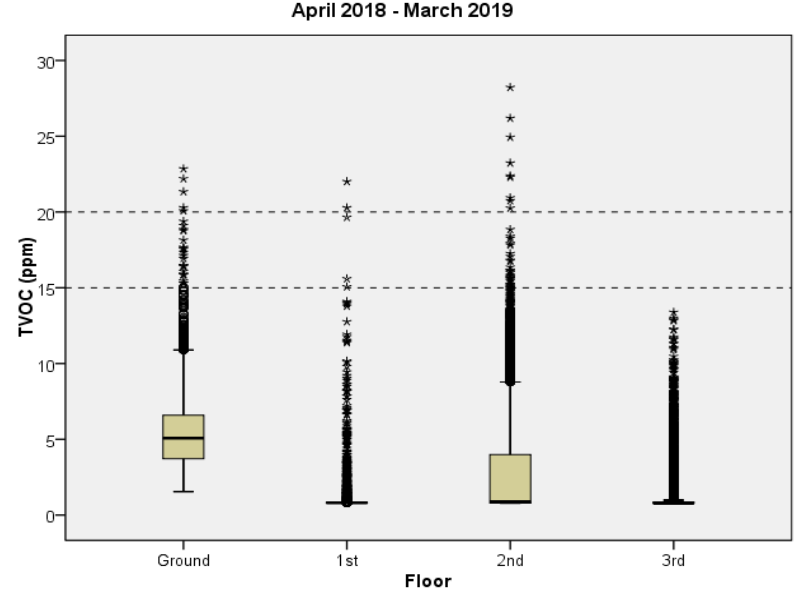
Figure 7. Boxplots of TVOC within each floor, for all experimental periods (April 2018–March 2019), along with the respective limit of exposure.